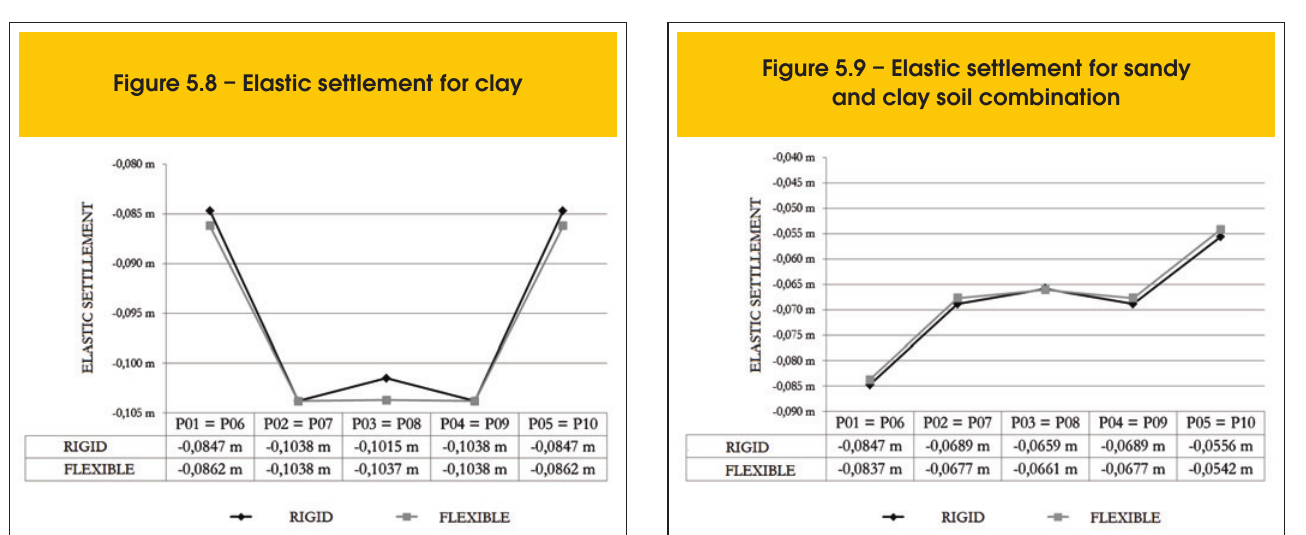
Figure 5.8 – Elastic settlement for clay